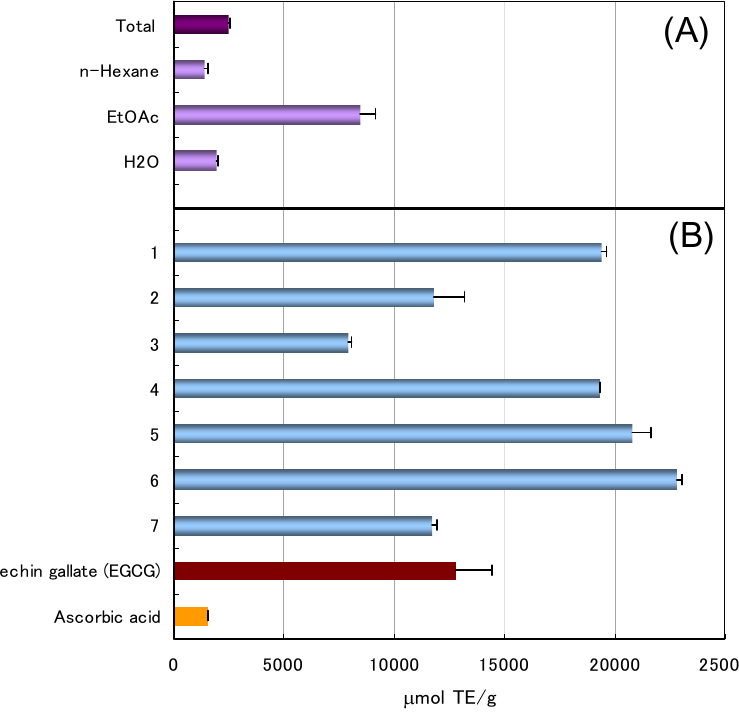
Figure 1. ORAC values of each fraction ( A ) and isolated compounds ( B